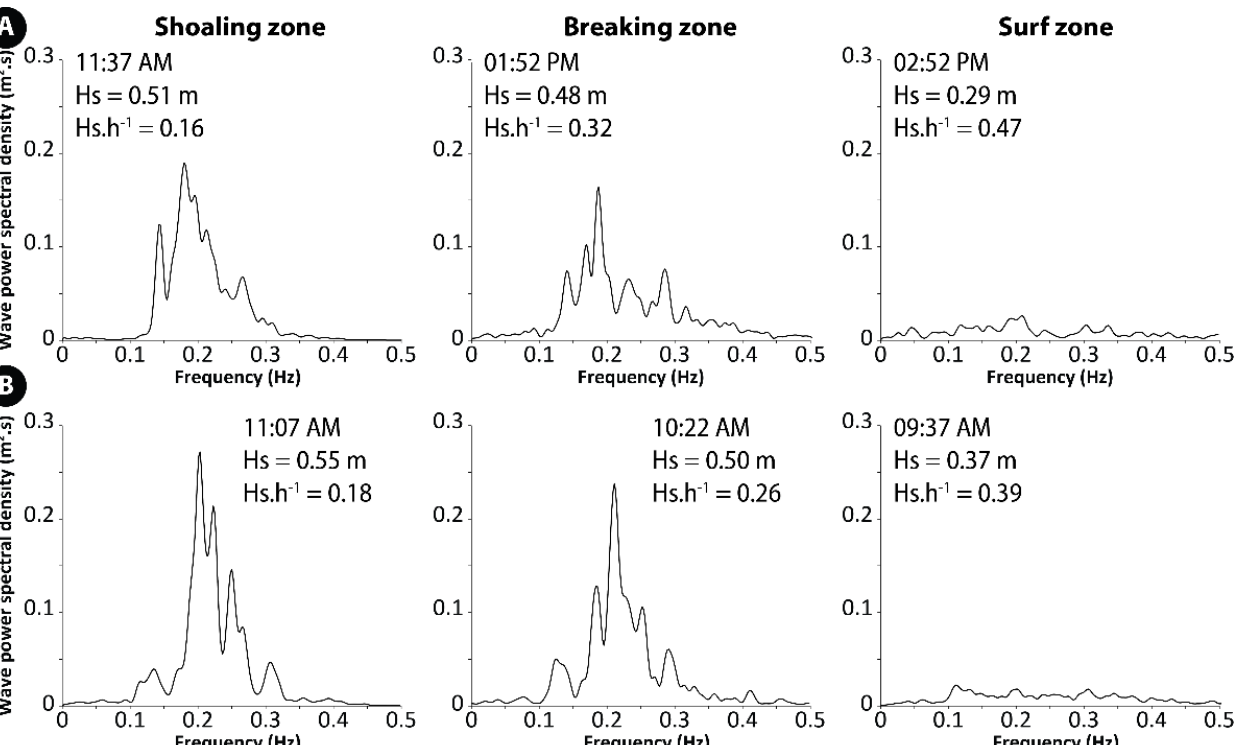
Figure 7. Examples of wave power density spectra computed from wave data recorded on bar B3 (see Figure 2D for location) under different wave processes (shoaling, breaking and surf) as water depth decreased during falling tide on ( A ) 4 June 2013 (high tide at 10:30 AM and low tide at 05:30 PM) and during rising tide on ( B ) 6 June 2013 (low tide at 07:00 AM and high tide at 12:15 PM).